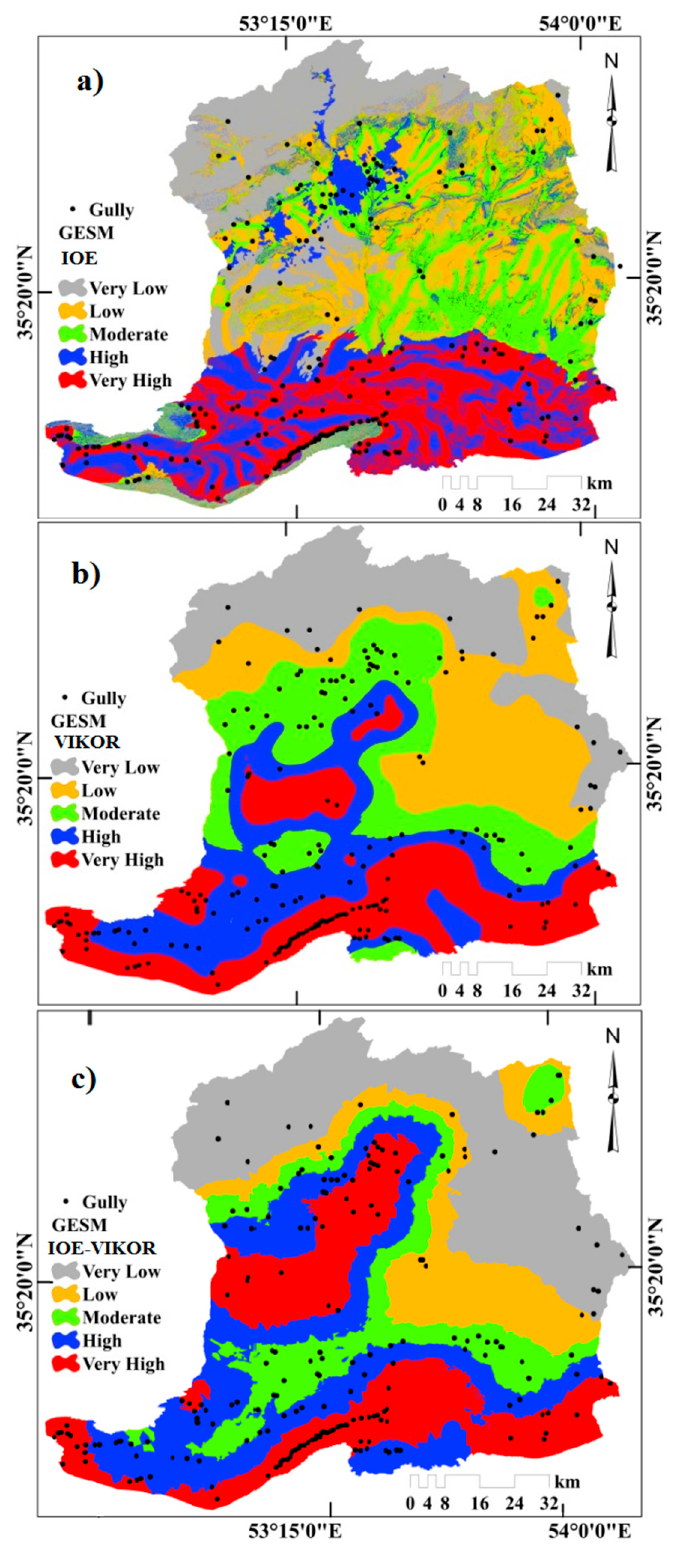
Figure 5. Gully erosion susceptibility mapping. ( a ) Index of entropy (IoE) model, ( b ) Vlse Kriterijumska Optimizacija I Kompromisno Resenje (VIKOR) model, ( c ) IoE-VIKOR integrated model.